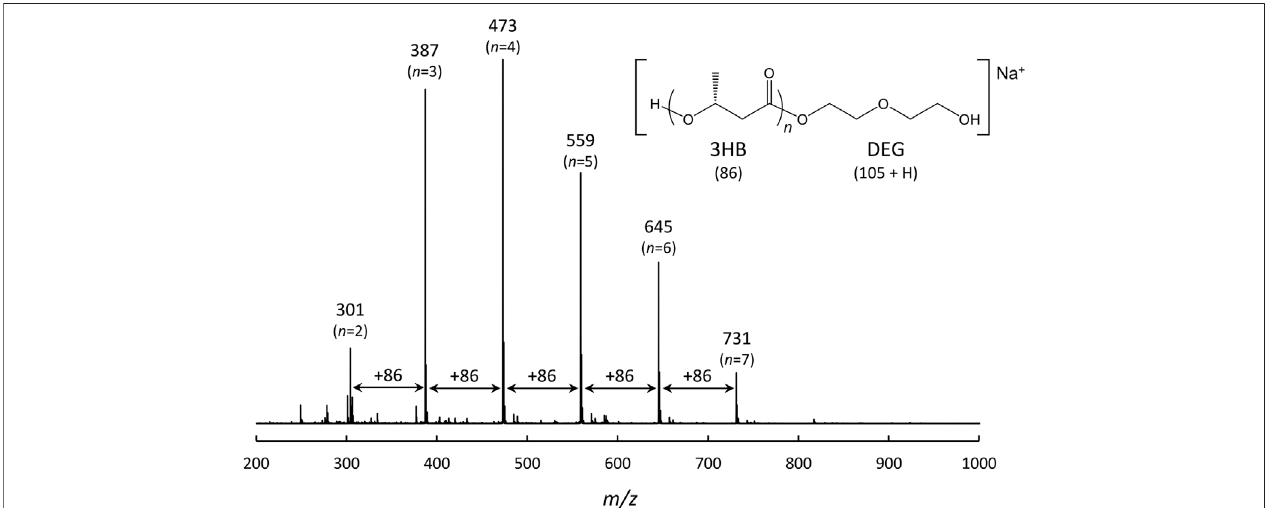
FIGURE5| ESITOF-MSspectrum of3HBO-DEGproduced bythebatchcultureof E.coli BW25113 Δ adhE harboring pGEM- phaRC YB4 AB inLBmedium,30 ° C,1 vvm, 600 rpm, pH uncontrolled for 48 h. ESI TOF-MS analysis was performed in the positive mode. The peak interval of m / z 86 indicates a 3HB repeating unit.